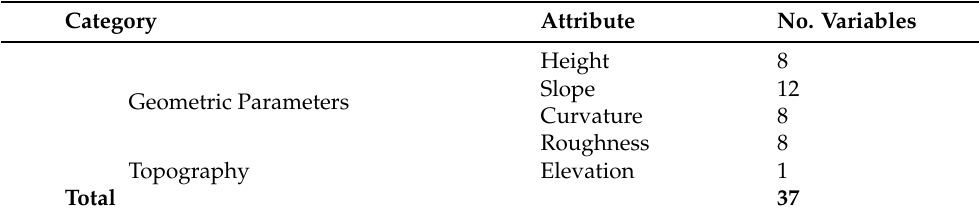
Table 2. For each attribute in the category geometric parameters, the four statistical measures mean, SD, min. and max. were calculated for the Digital Surface Models (DSM) and Canopy Height Model (CHM). An additional slope attribute for the DSM was considered. The topography category solely consists of the Digital Terrain Model (DTM) based elevation.